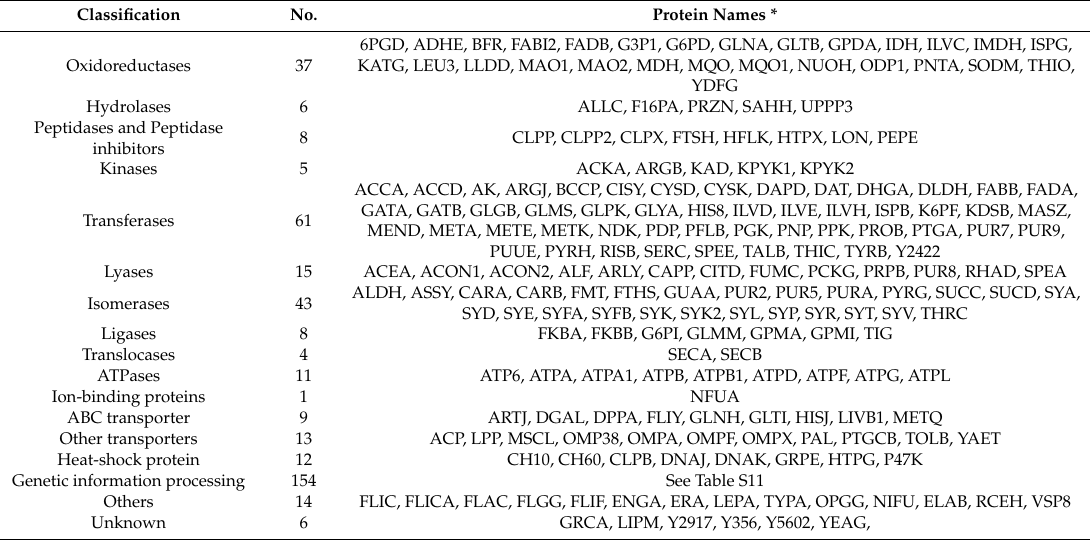
Table 6. Identified bacteria proteins from the GRH honeydew (matched peptides >